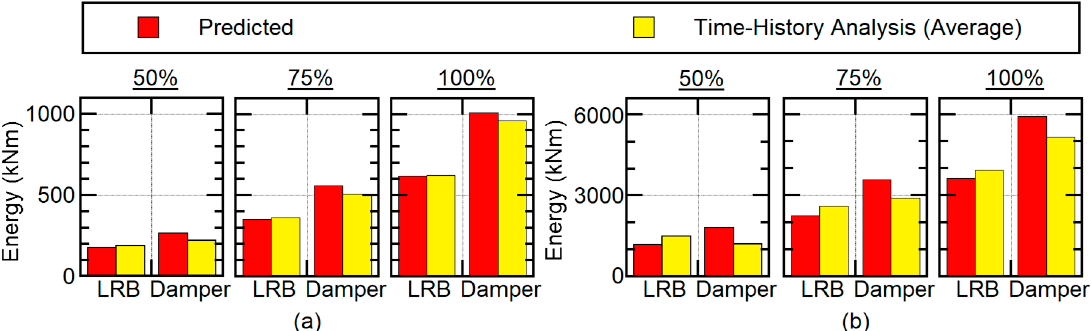
Figure 17. Comparisons of cumulative strain energy between isolators and dampers: ( a ) Art-S series; ( b ) Art-L series.